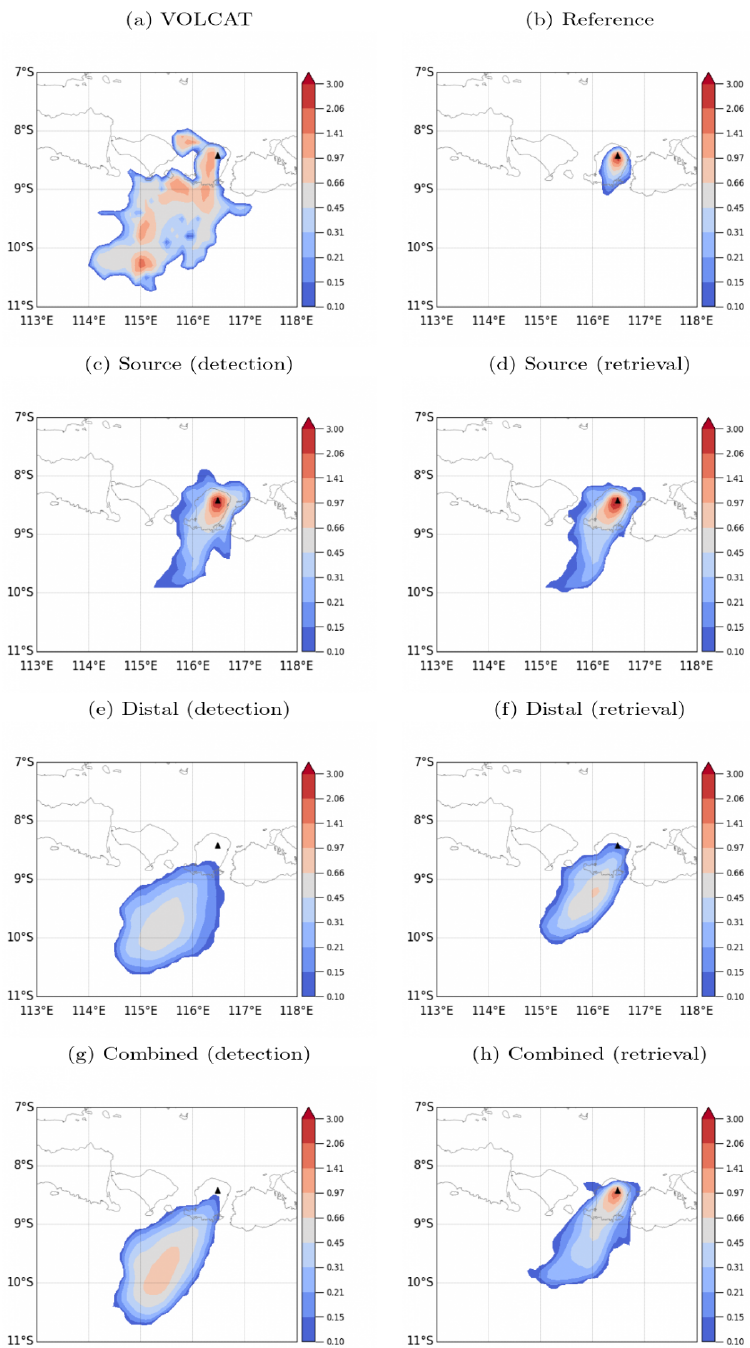
Figure 8. Mass load fields (in g/m 2 ) in the 4 November 2015 Rinjani eruption case study at 5/1430 UTC. The other details are the same as in Figure 7.